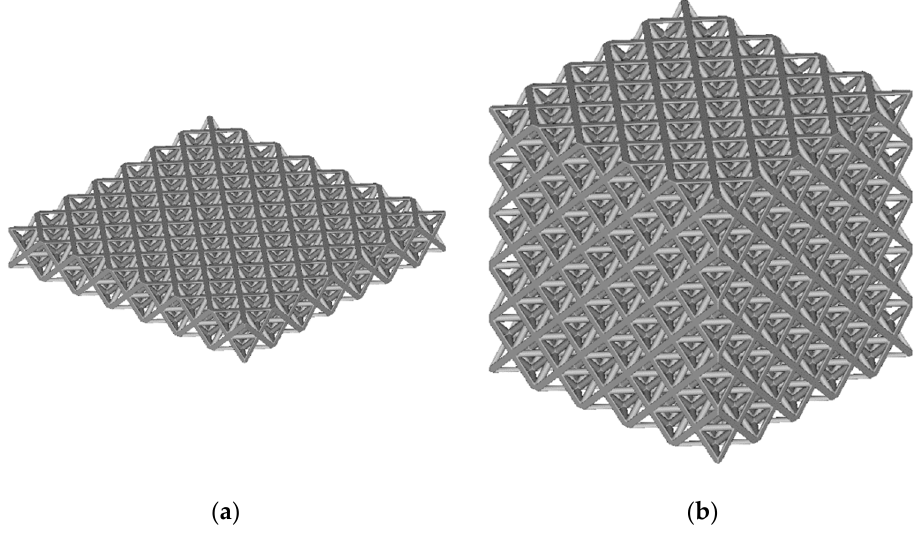
Figure 7. ( a ) 7 × 7 array of octet truss unit cells; ( b ) 7 × 7 × 7 array of octet truss unit